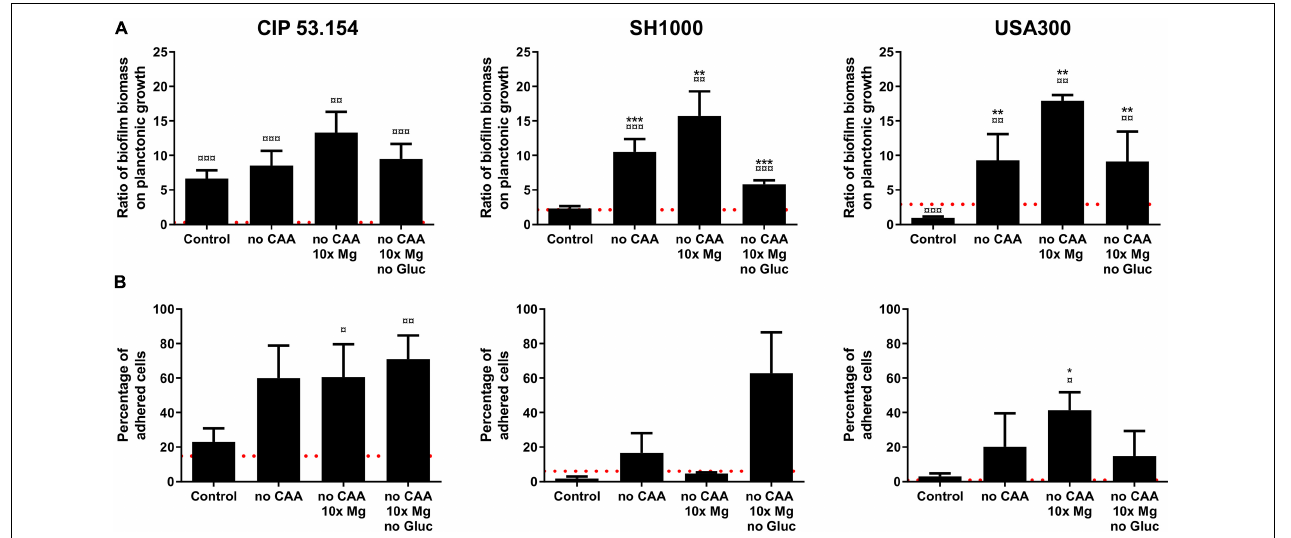
FIGURE 4 | Impact of starvation, magnesium excess, and hypoxia on S. aureus biofilm formation. Biofilms were grown in minimal medium (control) or modified minimal medium (no CAA, without casamino acids; 10 × Mg, 10 × minimal medium concentration; no Gluc, without glucose) without oxygen for 24 h before absorbance measurement and live adherent bacteria numeration. (A) Results represent the ratio of crystal violet absorbance (biofilm biomass) on planktonic growth absorbance. Experiments were performed at least four independent times with three technical replicates for each. (B) Results represent the percentage of live adherent bacteria among all bacteria. Experiments were performed at least four independent times with two technical replicates for each. Error bars represent standard errors for each average value. Red grid line represents results of biofilms grown with oxygen in minimal medium. Statistical analyses were performed using the exact non-parametric Wilcoxon–Mann–Whitney test for independent samples: ¤,¤¤,¤¤¤Statistically different from aerobic control ( p < 0.05; p < 0.01; p < 0.001); *, **, ***Statistically different from hypoxic control ( p < 0.05; p < 0.01; p < 0.001).